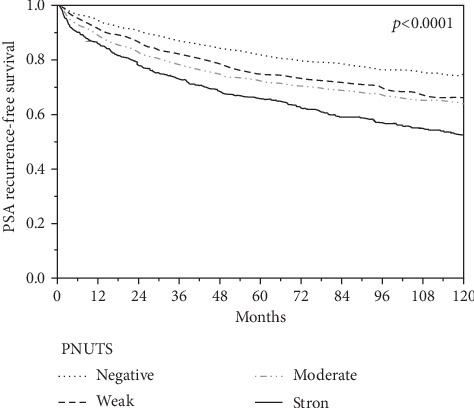
Association between PNUTS expression and biochemical recurrence after prostatectomy.